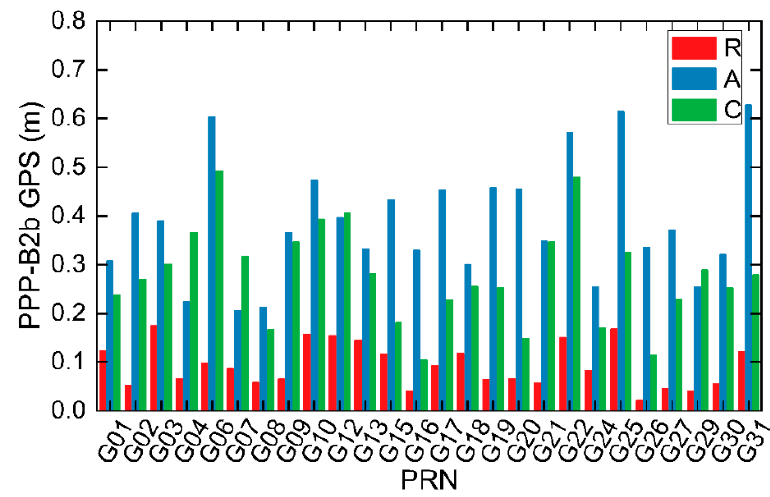
Figure 4. RMSEs of the CNES orbits for BDS-3 satellites.